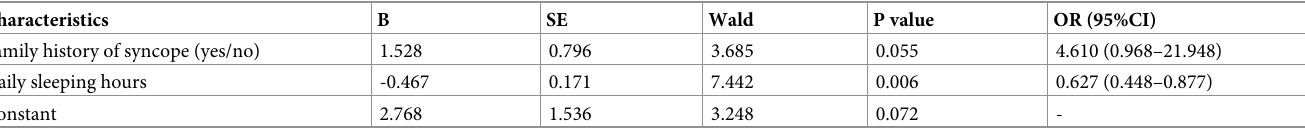
Table 3. Logistic multivariate regression analysis of